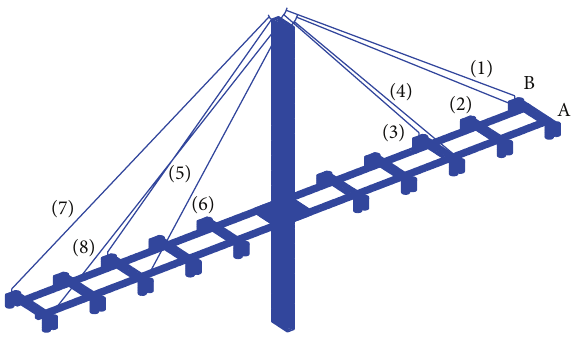
Figure 2: FE model of the bridge created by